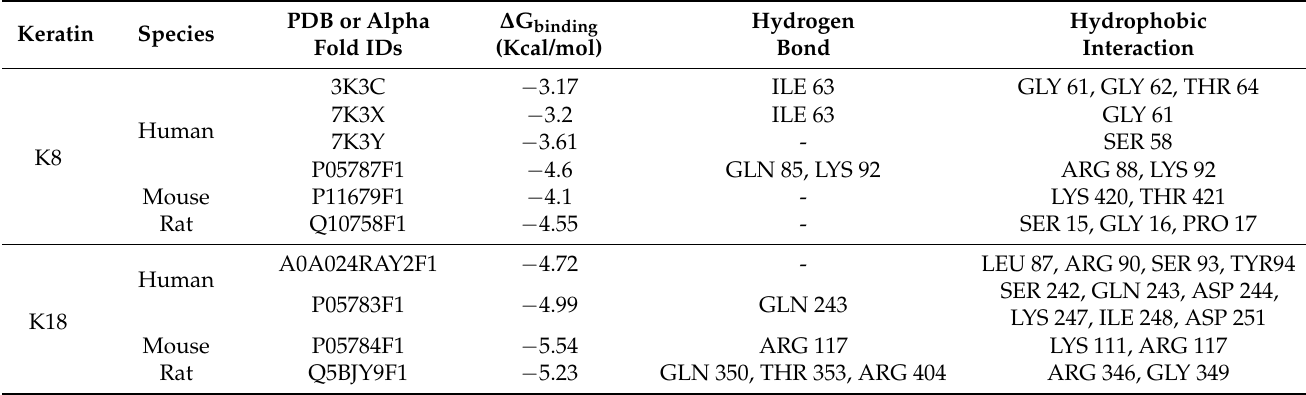
Table 1. Molecular docking details of griseofulvin interaction with keratin 8 (K8), and keratin 18 (K18) in human, rat, and